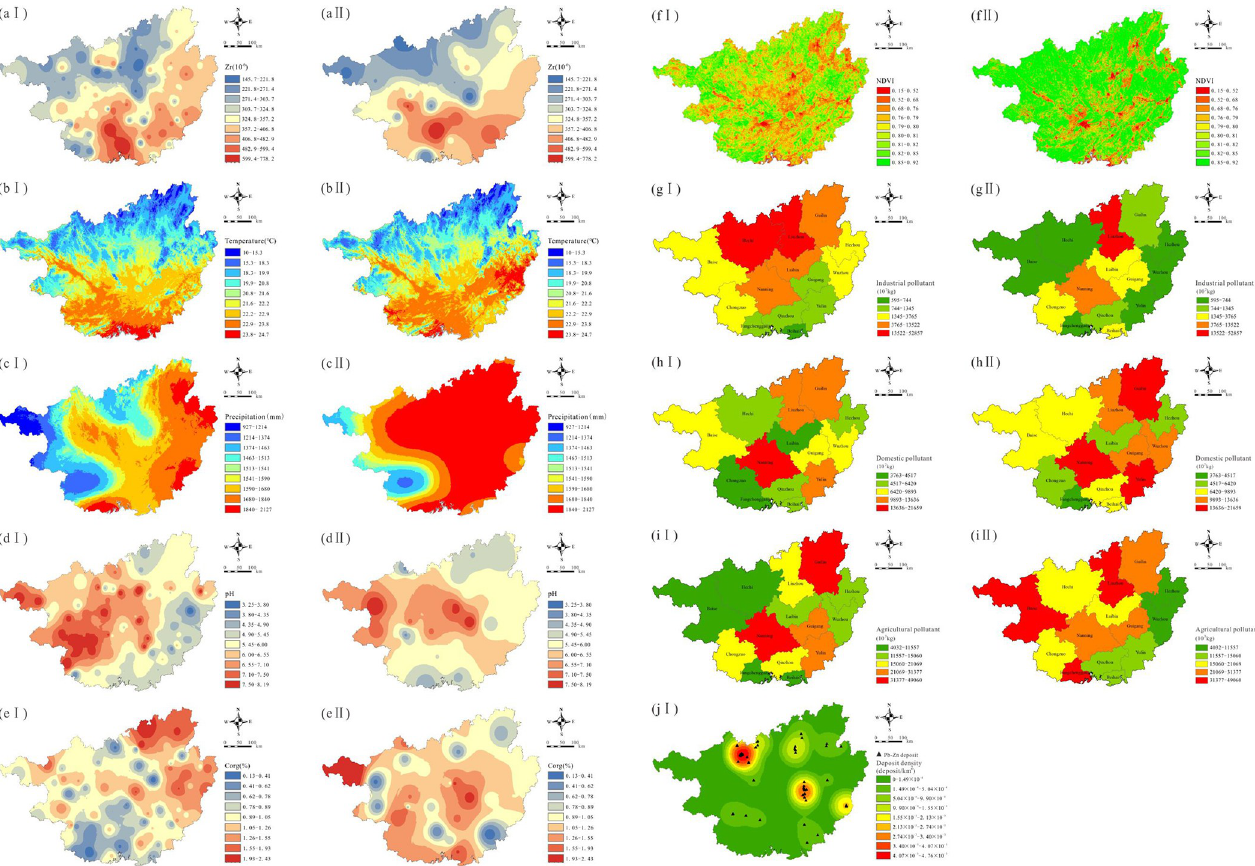
Fig 1. Spatial-temporal distribution of driving factors (a: Zr; b: Temperature; c: Precipitation; d: pH; e: Corg (organic carbon); f: NDVI; g: Industrial pollutants; h: Domestic pollutants; i: Agricultural pollutants; j: Deposit density; I for CGB I; II for CGB II).